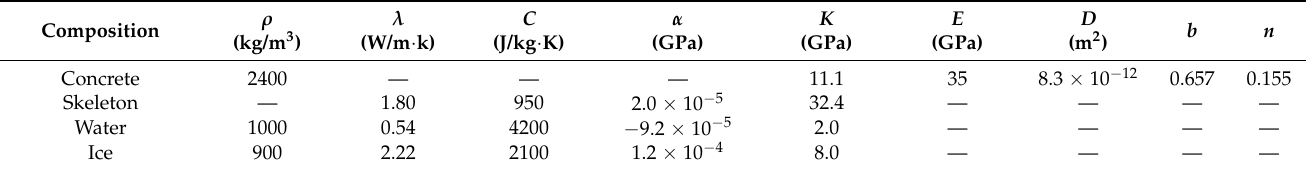
Table 1. Calculation parameters of the concrete lining.